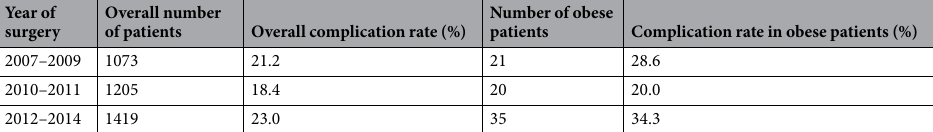
Table 6. Complication rate according to year of